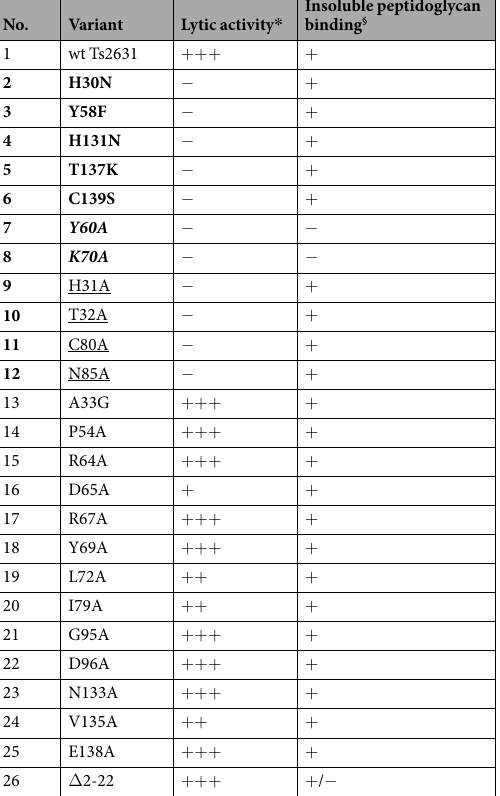
Table 2. Summary of properties of Ts2631 endolysin variants. The Ts2631 endolysin variants are grouped according to the effect of their mutation on the function; bold indicates residues responsible for bacteriolytic activity, italic indicates residues essential for peptidoglycan binding, and underline defines residues located in the PGN-binding groove that participate in the substrate binding, as indicated by comparative analysis with eukaryotic PGRPs. * Lytic activity was estimated by spectrophotometric measurements of the decrease in the turbidity of a chloroform-treated T. thermophilus HB8 suspension after the addition of the specified variant: +++ more than 60% activity relative to wild-type Ts2631 endolysin; ++ between 50 and 60%; + between 30 and 40%; − less than 20% or no visible activity. § Insoluble peptidoglycan binding activity was measured by a PGN binding assay: + binding; − no binding; + / − the protein was predominantly in the unbound